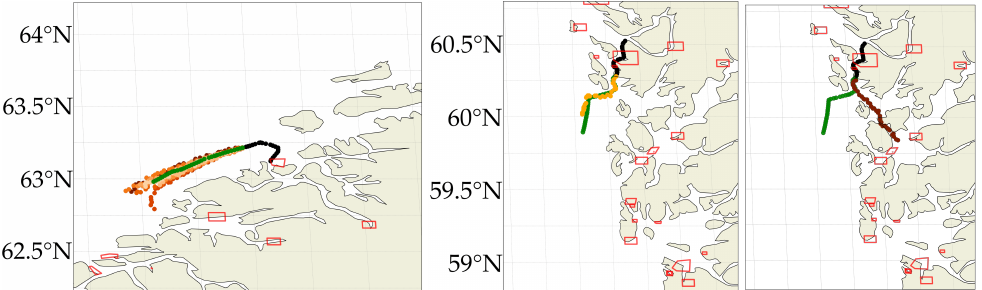
Figure 7. Model predictions with the input sample illustrated in black, the true trajectory in green and the predicted samples in shade of orange. Nearby harbours are shown in red polygons. The predicted trajectory avoid land and follows different probable